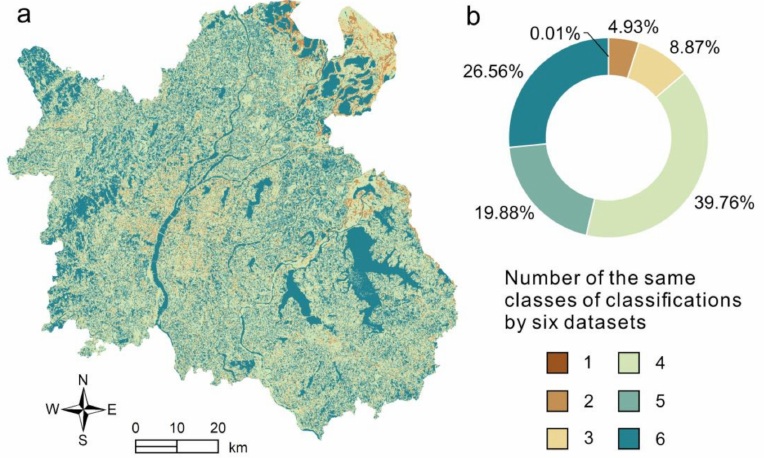
Figure 6. Difference ( a ) and its percentages ( b ) between six LCZ maps using different datasets ( D1–D6 ). The difference is presented as the number of the same classes for individual cells of the